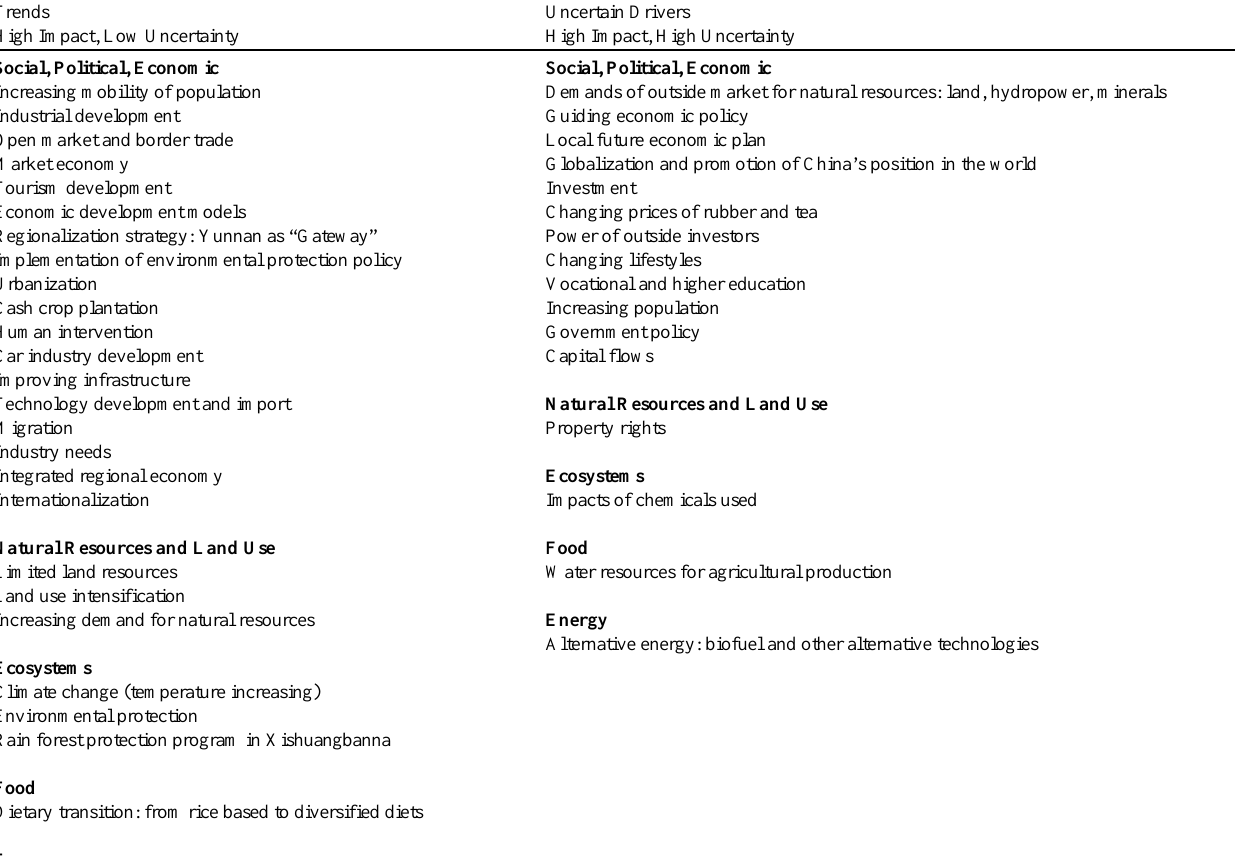
Table 1 . Example of initial scenario framework. Source: After Xishuangbanna workshop in Foran et al.